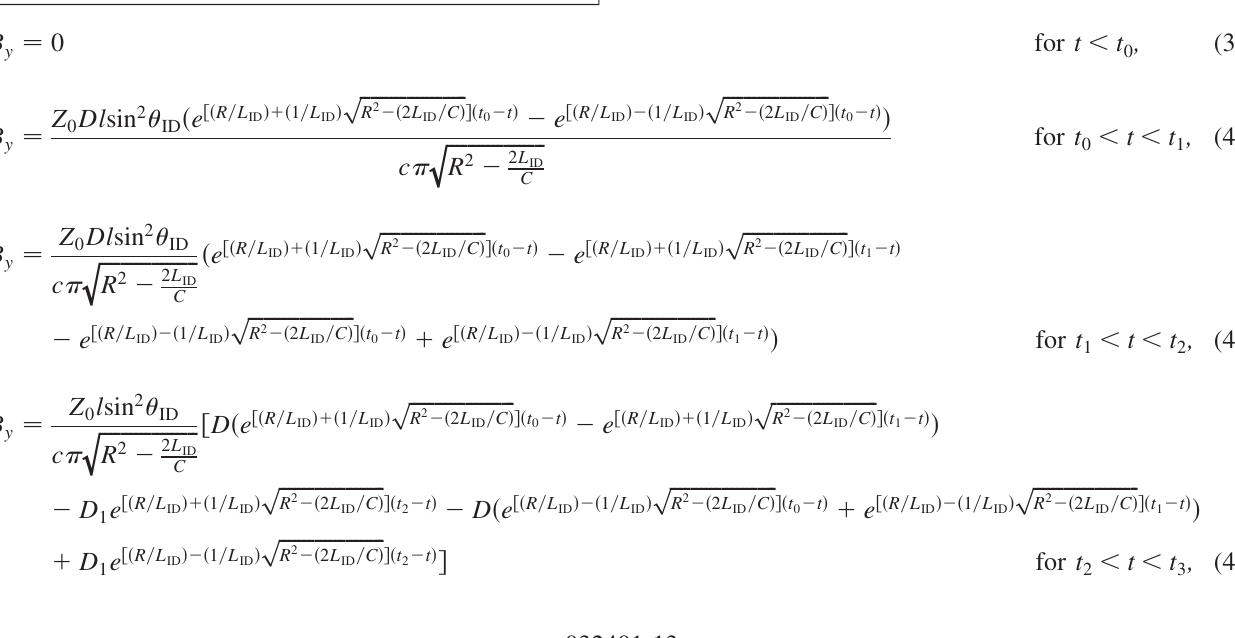
ffiffiffiffiffiffiffiffiffiffiffiffiffiffiffiffiffiffiffi p ffiffiffiffiffiffiffiffiffiffiffiffiffiffiffiffiffiffiffi R 2 (cid:1)ð 2 (cid:4) j =C Þ